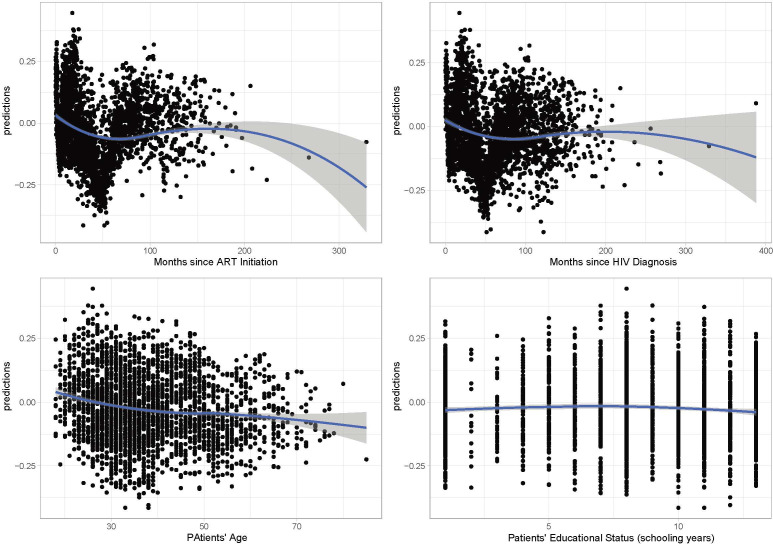
Heterogeneity plots for employment.